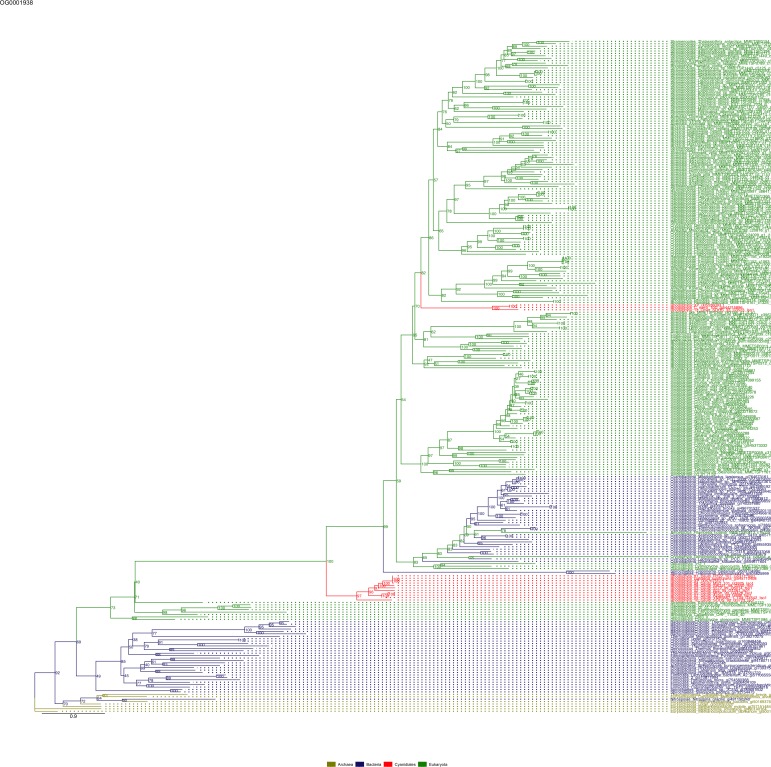
Sequence tree of orthogroup OG0001938.The tree is based on amino acid sequences. Archaea (yellow), Bacteria (blue), Cyanidiales (red), Eukaryotes including other red algae (green). Branches containing Cyanidiales sequences are highlited in red.